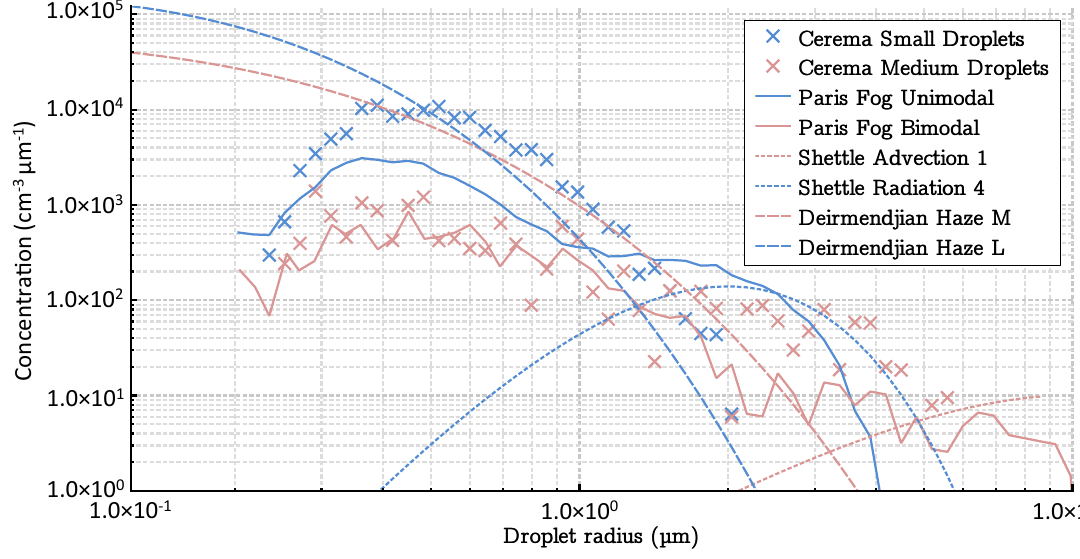
Figure 3. Examples of droplet size